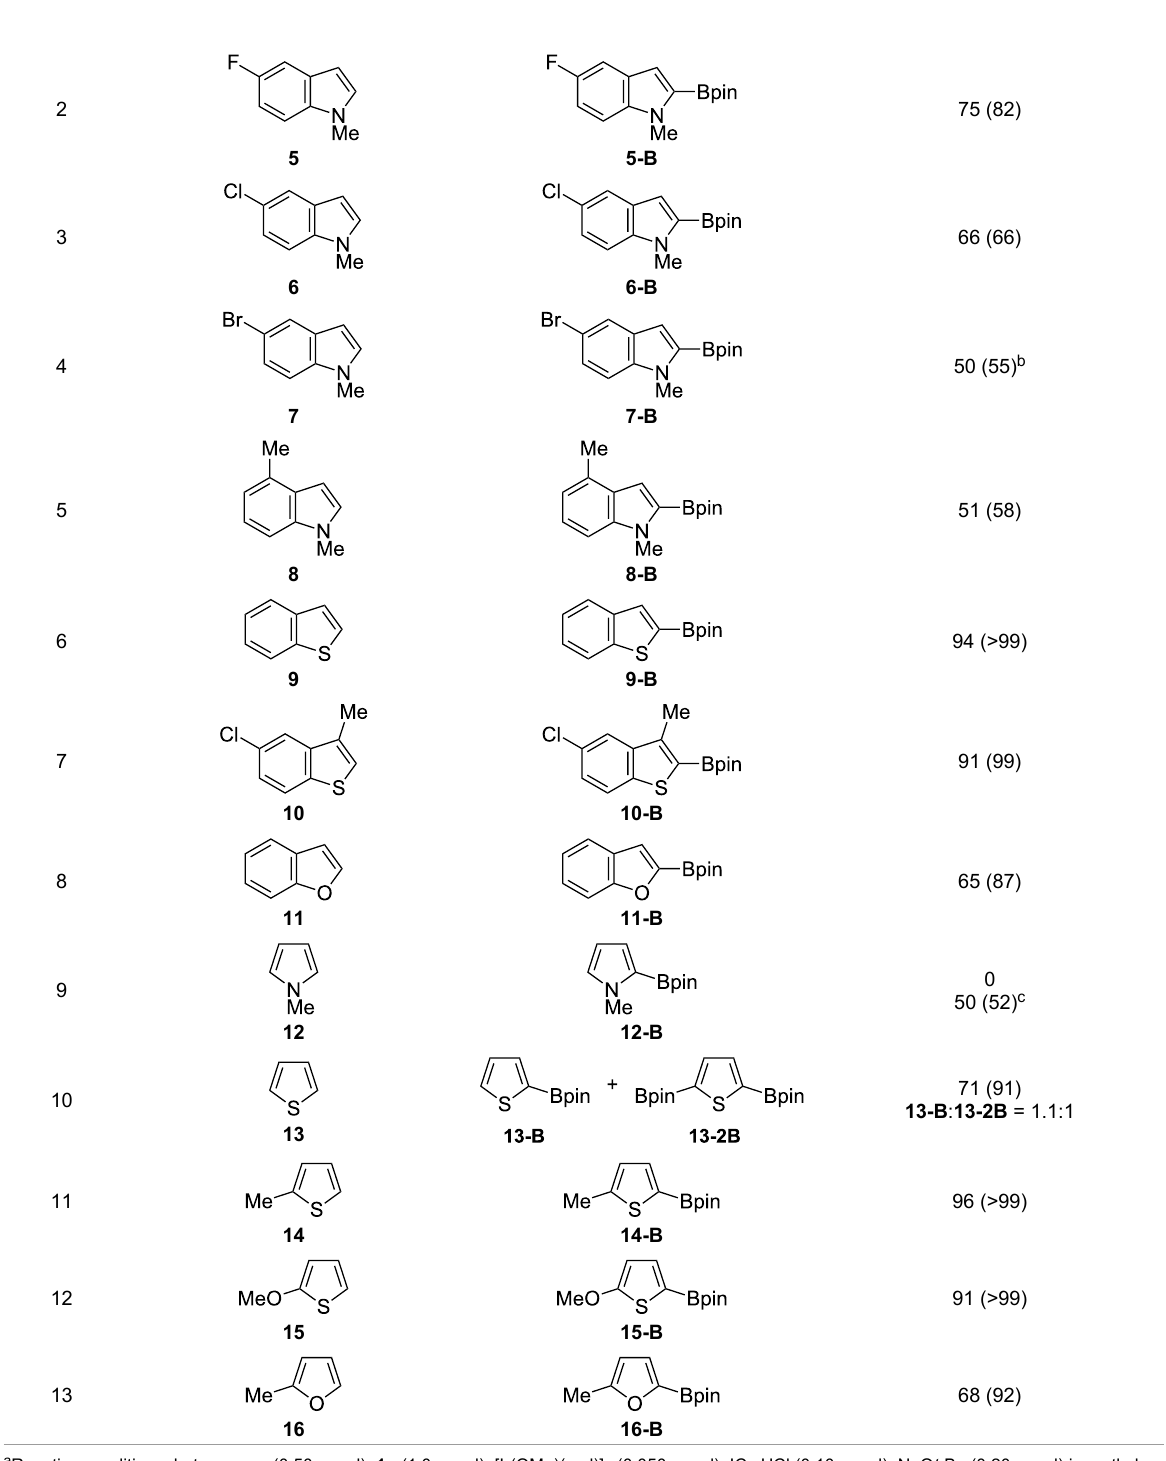
Table 2: Scope of the heteroarene substrates. a